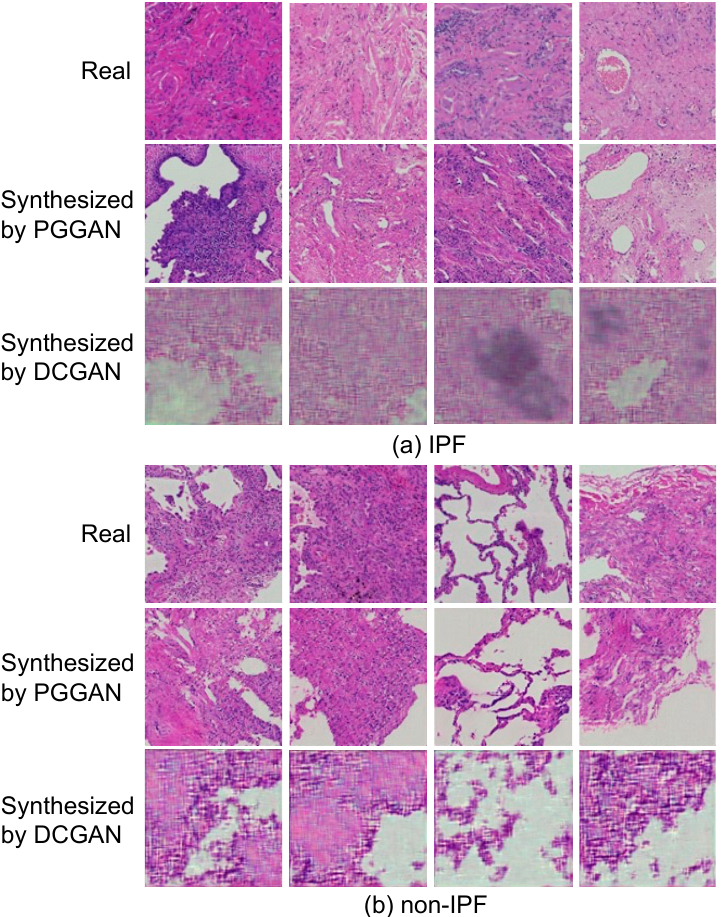
Figure 6. Real and synthesized images generated using PGGAN and conventional DCGAN models. ( a ) Images of IPF; ( b ) Images of non-IPF.